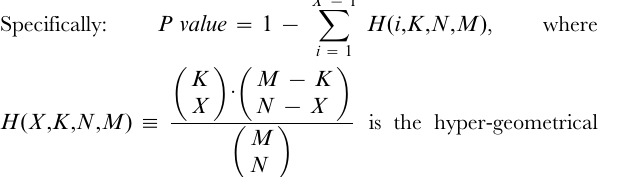
Figure S2 Response of cells grown in steady state to environ- mental perturbations